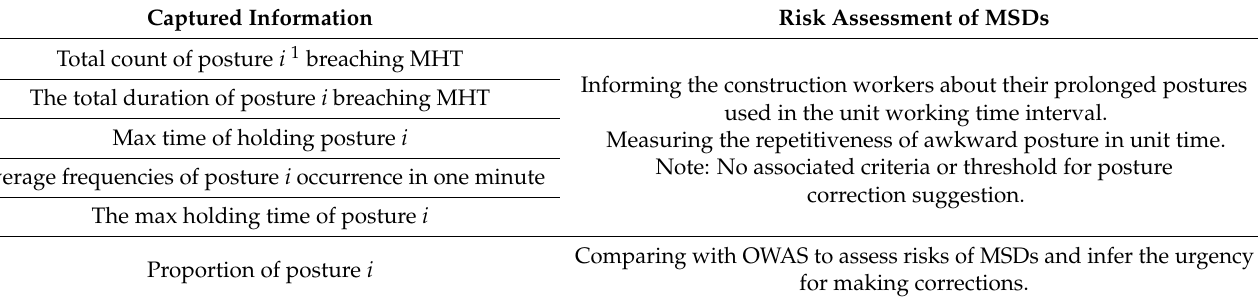
Table 3. Periodic MSDs risk assessment for individual